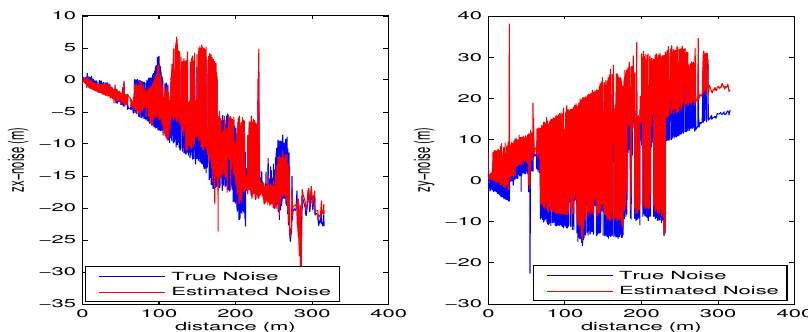
Figure 7. The comparison of true and estimated measurement error data.